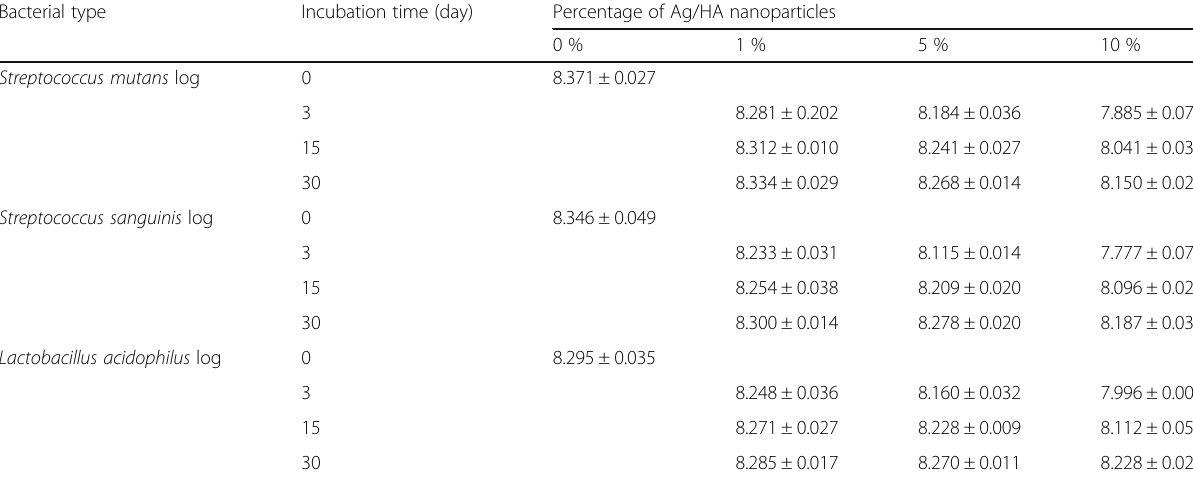
Table 2 Logarithm of bacterial count in liquid media after 3, 15, and 30 days Bacterial